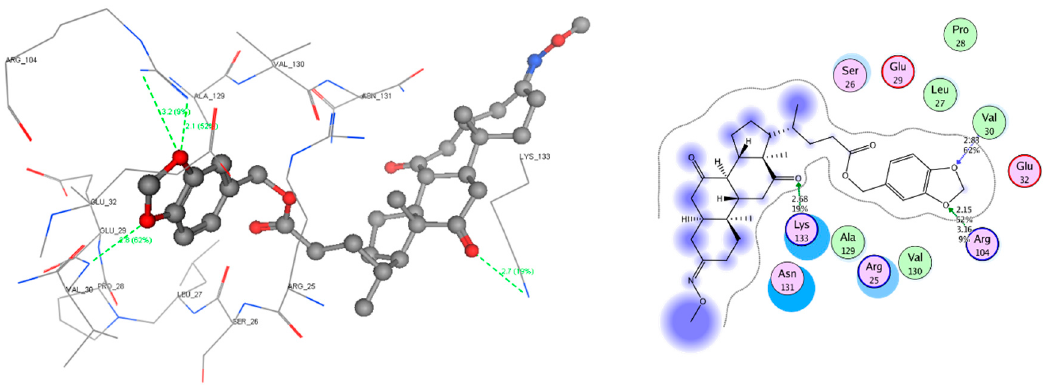
Figure 6. Theoretical Binding mode of compound 2b-3 in heparan sulfate proteoglycan (HSPG) (PDB: 3sh5) in 3D and 2D.